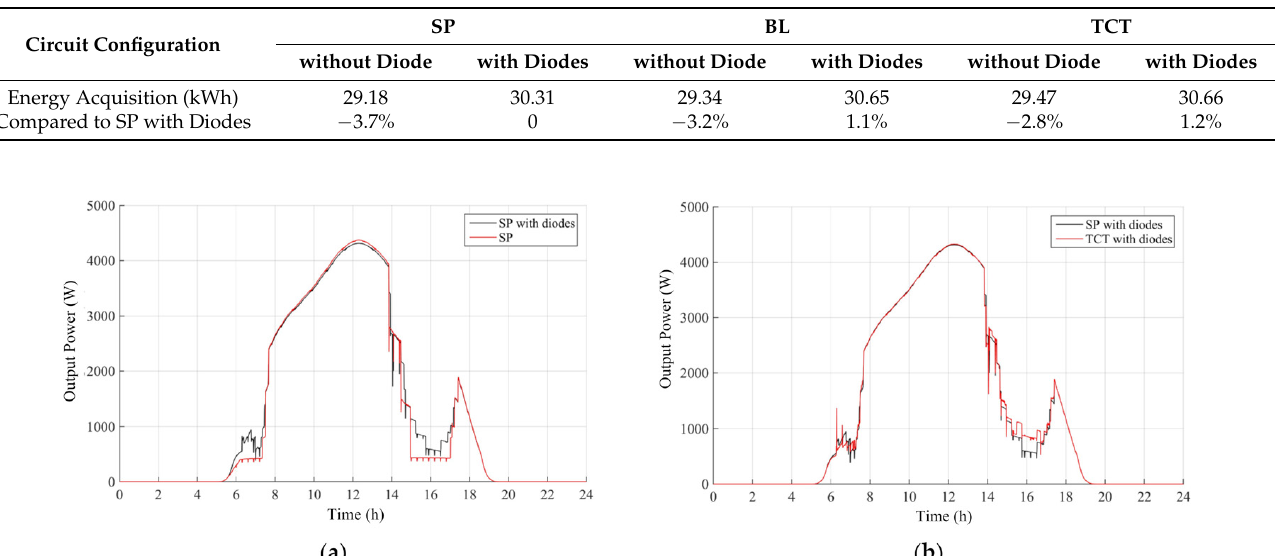
Figure 12. Models of different PV configurations. ( a ) SP circuit configuration. ( b ) BL circuit configu- ration. ( c ) TCT circuit configuration. Table 3. Energy acquisition of wing section 3 in a day of different PV configurations.